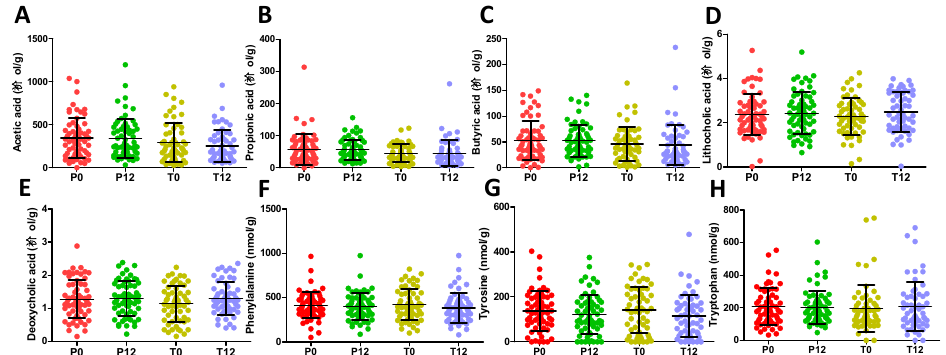
Figure 6. Concentrations of short chain fatty acids, secondary bile acids, and AAA in P0, P12, T0, and T12 fecal samples. ( A ) Acetic acid. ( B ) Propionic acid. ( C ) Butyric acid. ( D ) Lithocholic acid. ( E ) Deoxycholic acid. ( F ) Phenylalanine. ( G ) Tyrosine. ( H ) Tryptophan.